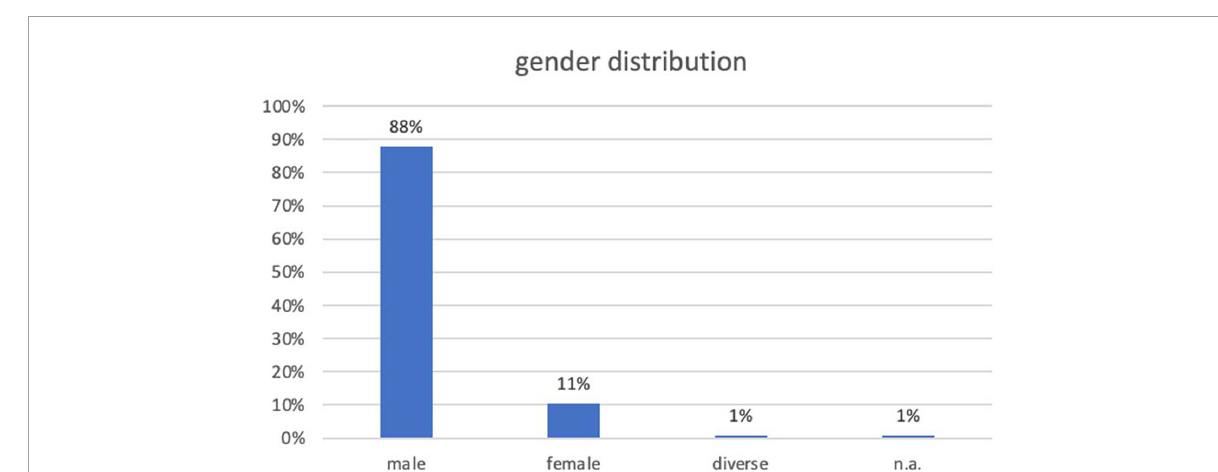
FIGURE5 Age distribution.